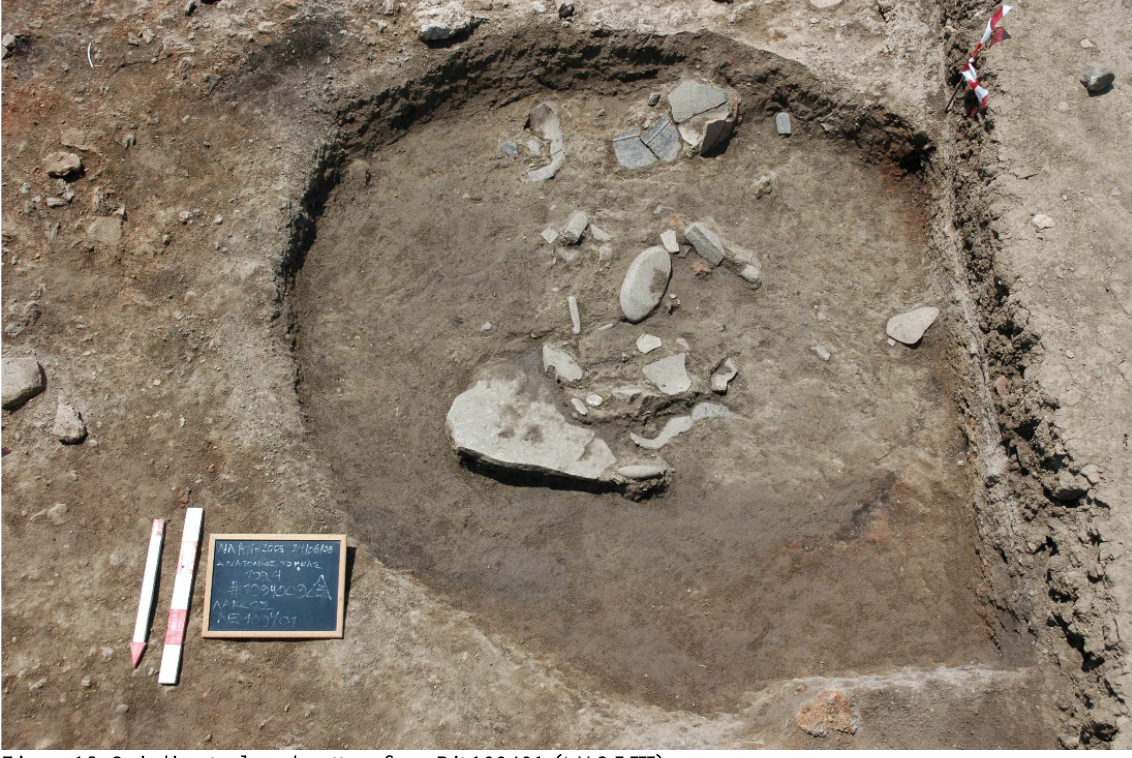
Figure 18. Grinding tools and pottery from Pit 109401 (AVGI